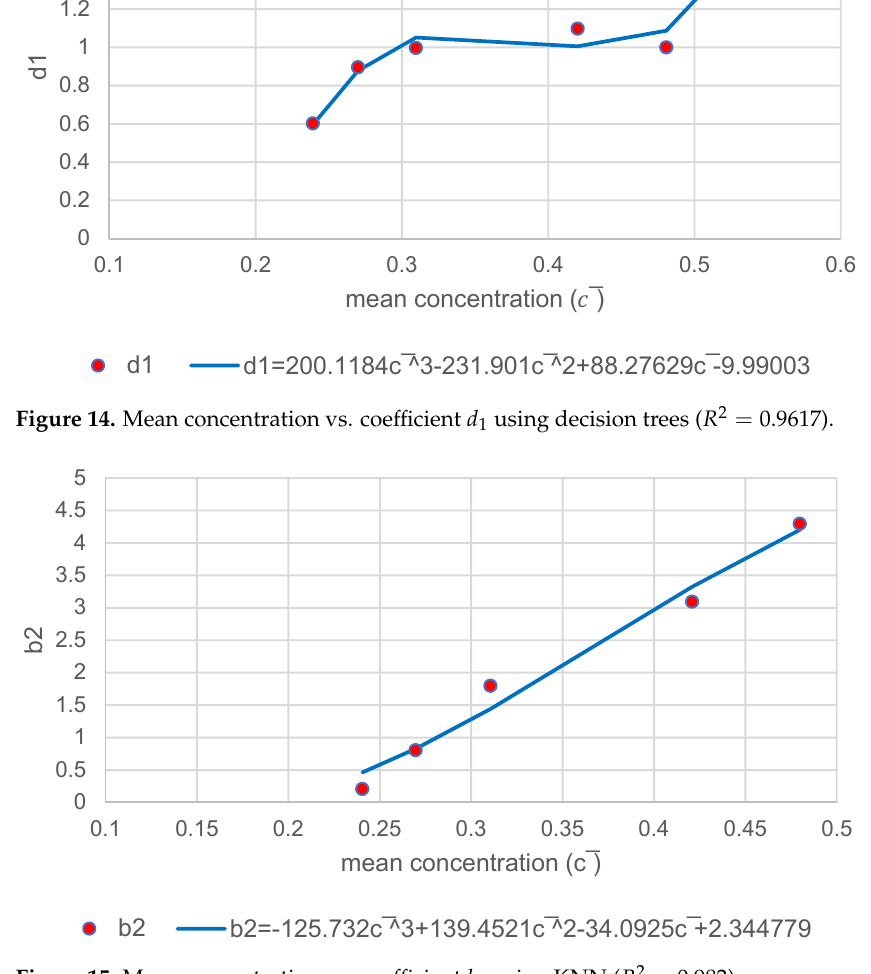
Figure 15. Mean concentration vs. coefficient b 2 using KNN ( R 2 = 0.982 ).